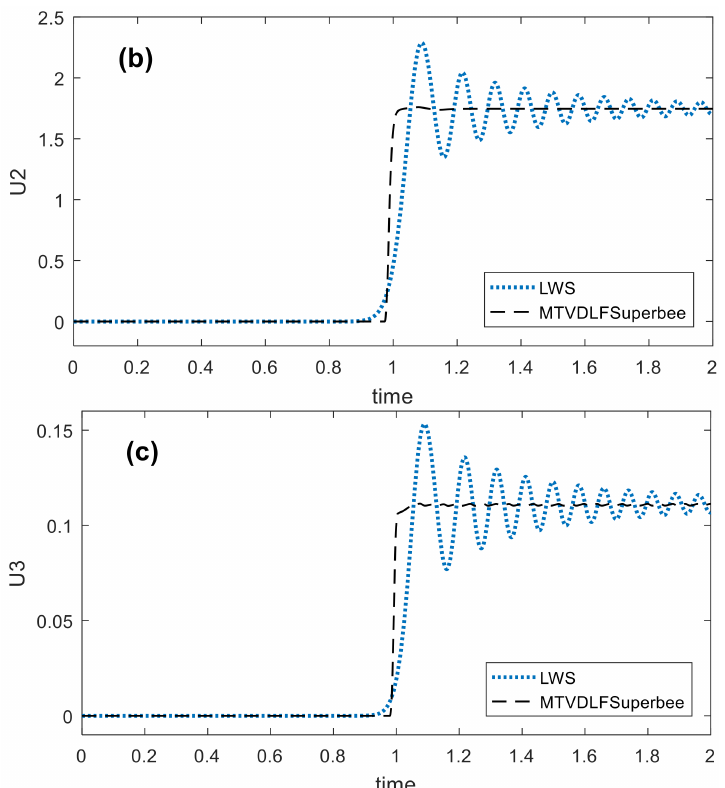
Figure 7. Comparisons of LWS and MTVDLF-Superbee scheme for autocatalytic reaction model with three-component reactants at X = 0.5 with V = 0.5. Concentration distribution along the reactor for ( a ) species A ( b ) species B and ( c ) species